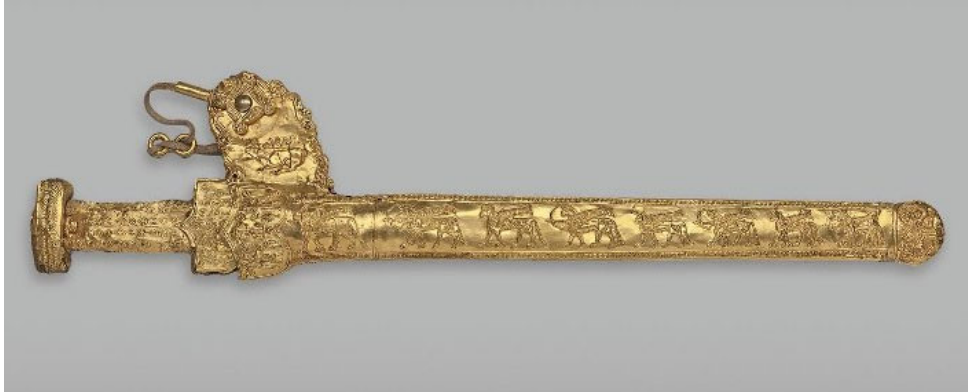
Figure 22. Akinakes in Sheath with a stamped ornament . 7th century BC. Gold, iron. 47 × 14.1 cm